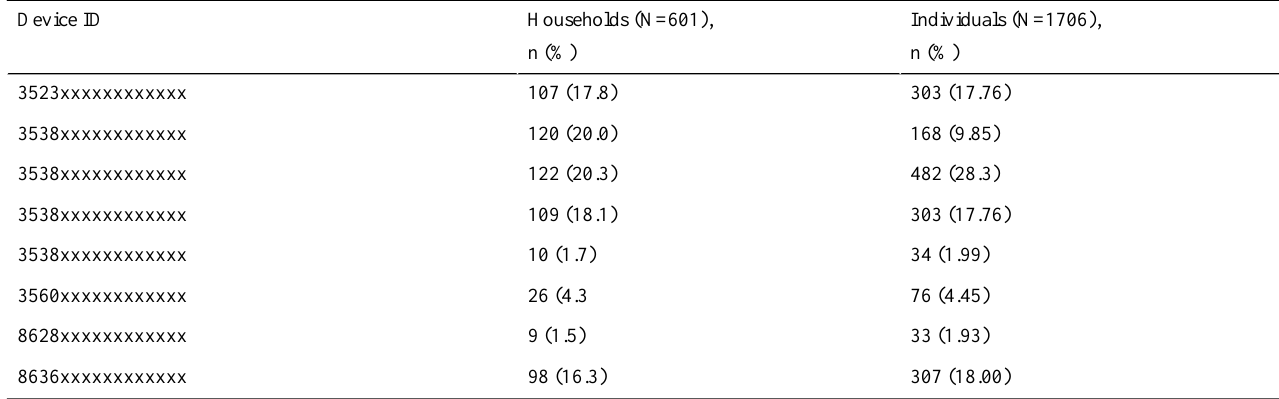
Table 1. Number of data entries for households and household occupants per device